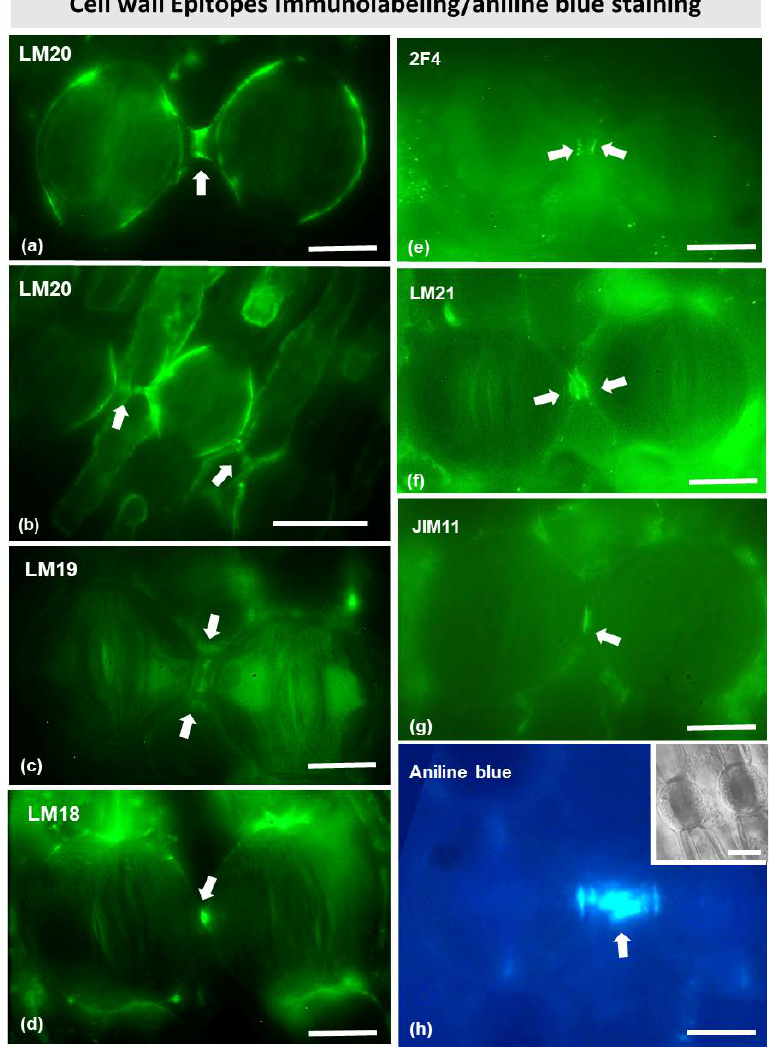
Figure 9. Immunolabeling of cell wall epitopes ( a – g ) and aniline blue fluorescent staining ( h ) in stomata of Pancratium maritimum epidermis. In all panels, arrows point to sites with intense fluores- cent signal. ( a , b ) LM20 (fully methylesterified homogalacturonans) immunolabeling of two ( a ) and three ( b ) adjacent stomata. When the connecting strand is relatively short ( a ), the LM20 signal is detected at the dorsal cell walls and at the middle of the strand. When it is relatively long ( b ), it seems absent from the middle of the cell wall strand. ( c – e ) LM19, LM18 and 2F4 immunolocalization (unesterified homogalacturonans, partially demethylesterified homogalacturonans, and partially demethylesterified homogalacturonans with 40% calcium bridges, respectively) immunolabeling of two adjacent stomata. LM19 and LM18 signal is detected at the middle of the connecting strand ( c , d ) while 2F4 is located at the junctions of the strand with the dorsal cell walls ( e ). ( f ) LM21 (man- nans) immunolabeling of two adjacent stomata. The signal is detected at the dorsal cell walls and at the middle of the connecting strand. ( g ) JIM11 (extensins) immunolabeling of two adjacent stomata, where the signal is detected at the connecting strand. ( h ) Aniline blue staining provides intense signal at the connecting strand. Inset: representative stomata in DIC. Scale bars: 10 µ